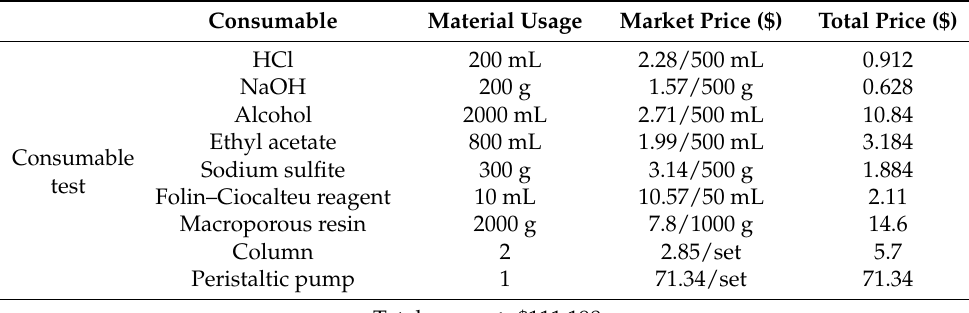
Table 5. Costs produced from the extraction of monomeric phenols from thinned fruits.